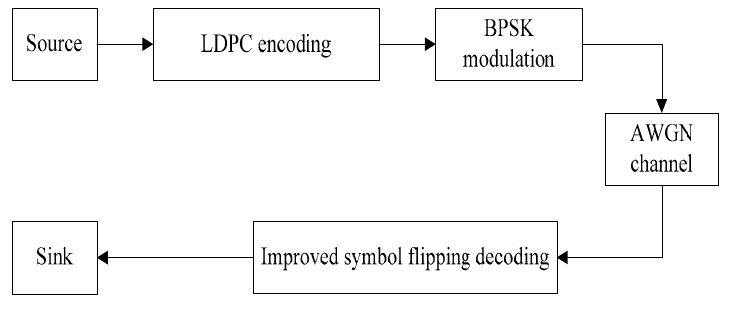
Figure 2. The link level simulation block diagram.